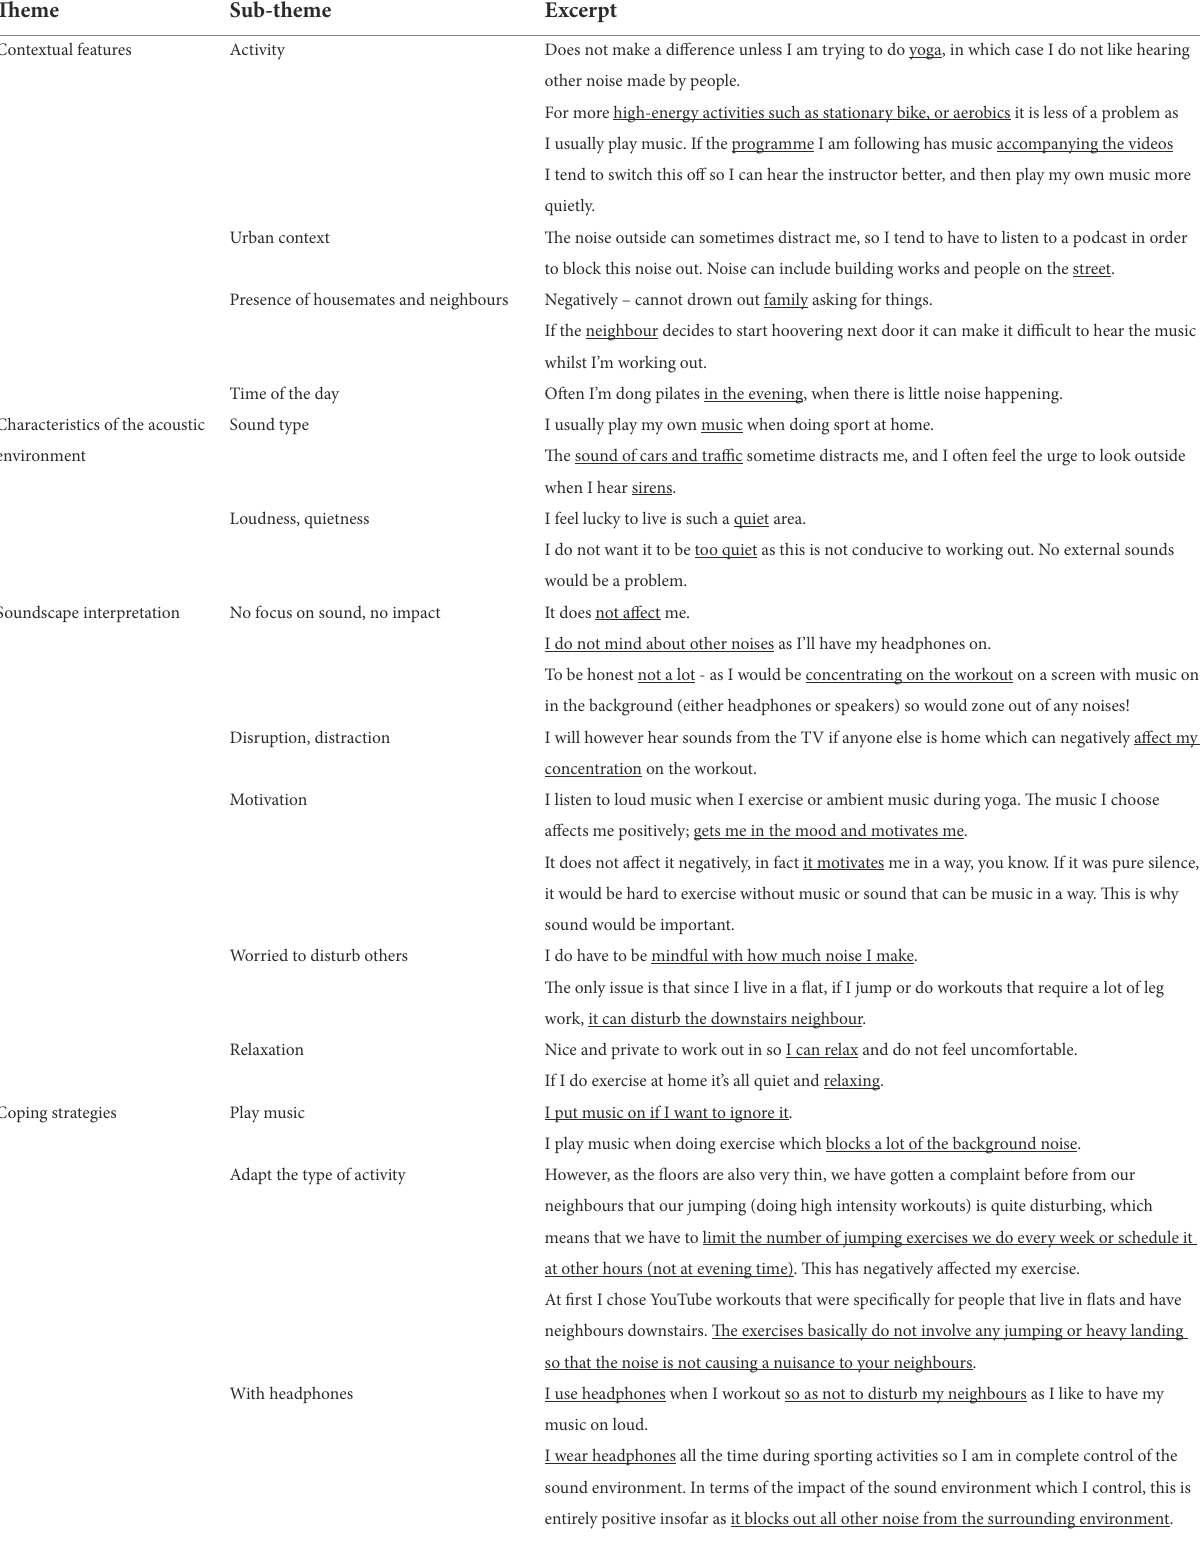
TABLE 4 Example of excerpts and coded fragments (underlined) related to themes and sub-themes defined from the thematic analysis for soundscape impacts on home workout.